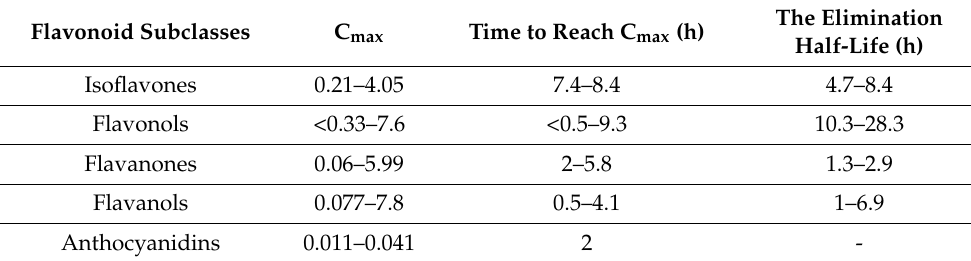
The Elimination Half-Life (h)